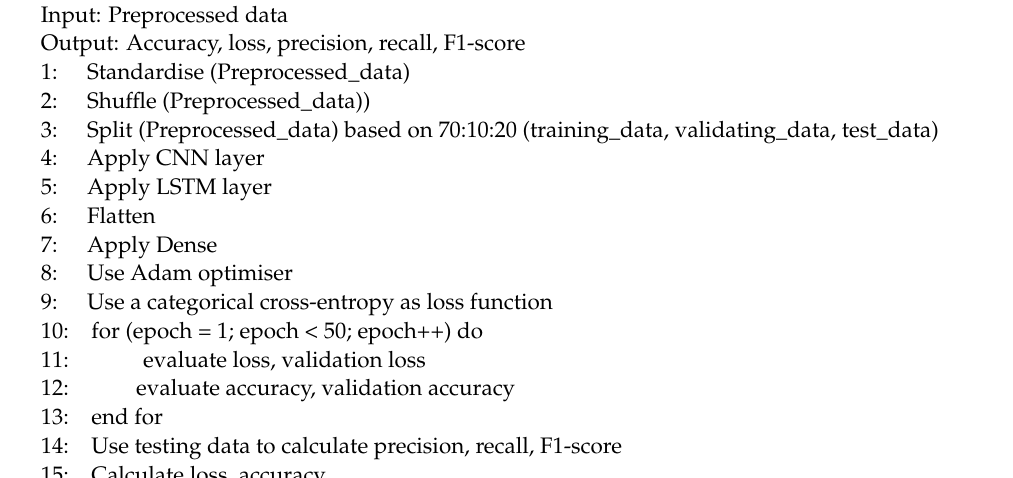
Algorithm 1 Algorithm for the proposed model